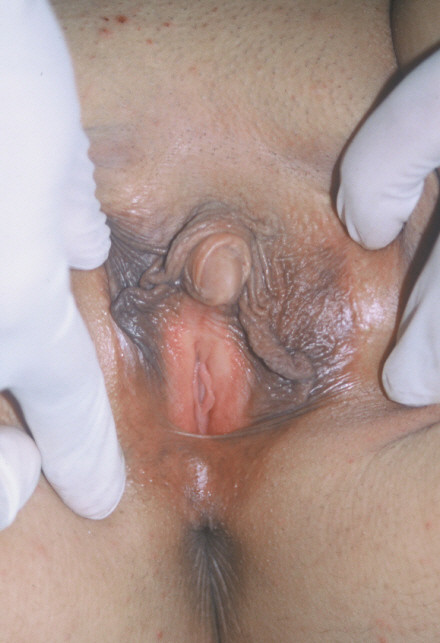
View of the Case 1.